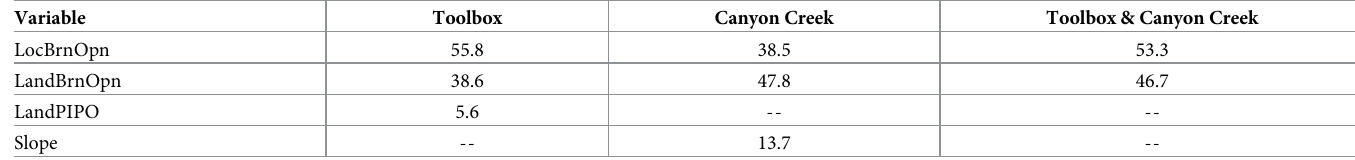
available for nesting also varied among locations (see non-nest sites, Table 3). Toolbox and Canyon Creek locations were characterized by greater coverage of ponderosa-dominated for- est (LandPIPO), smaller trees (DBH), and less severely burned or less open canopies at a land- scape scale (LandBrnOpn) than at Barry Point. Logging at Toolbox was more intense (LogIntensity) and more extensive (LocLog, LandLog) at nest compared to non-nest sites, whereas this pattern did not hold at Canyon Creek (Table 3). Maxent models consistently retained local- and landscape-scale percent area burned or open (LocBrnOpn and LandBrnOpn) variables as primary contributors (Table 4). Maxent HSIs described positive and negative nest habitat relationships with LocBrnOpn and Land- BrnOpn, respectively (Fig 2). LandPIPO also contributed to the Toolbox model and Slope to the Canyon Creek model (Table 4). At Toolbox, Maxent HSIs related positively with ponder- osa-pine dominated forest, and at Canyon Creek, HSIs related negatively with topographic slope (Fig 2). These covariates represented relatively minor contributions, however, and were not retained in the pooled model (Table 4). Table 4. Variable contributions (% gain) for Maxent models developed with remotely sensed data measured at white-headed woodpecker nest and available sites in burned forest (Oregon, USA). Models at individual locations (Toolbox, Canyon Creek) were evaluated for transferability before pooling (Toolbox & Canyon